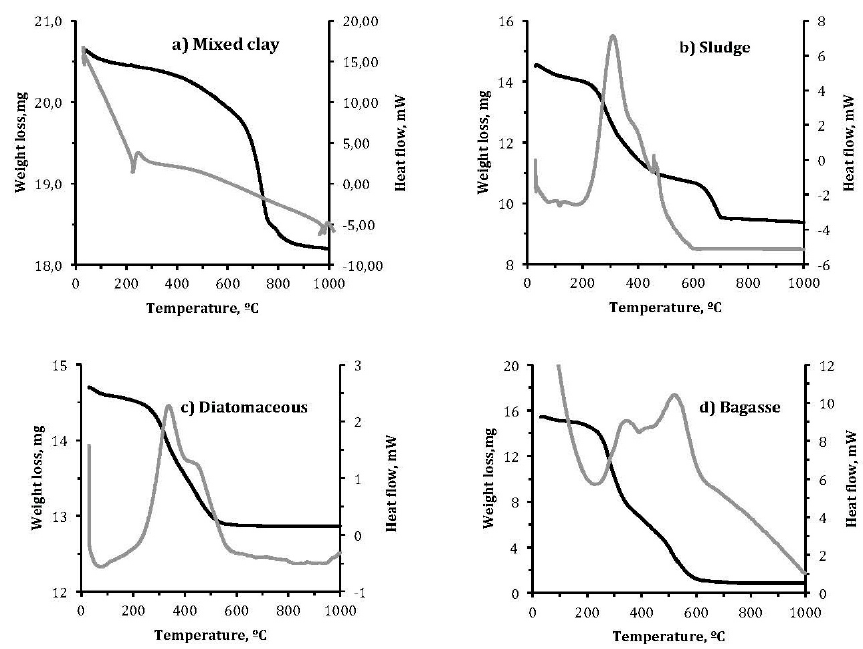
Figure 4. Thermogravimetric Analysis (TGA) and Differential Thermal Analysis (DTA) curves of: ( a ) mixed clay; ( b ) sludge; ( c ) diatomaceous; and ( d ) bagasse.